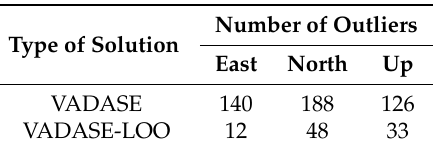
Table 1. Number of outliers in the 3D velocity variometric solutions over 67 days (3 February–9 April 2016) at the M0SE IGS permanent